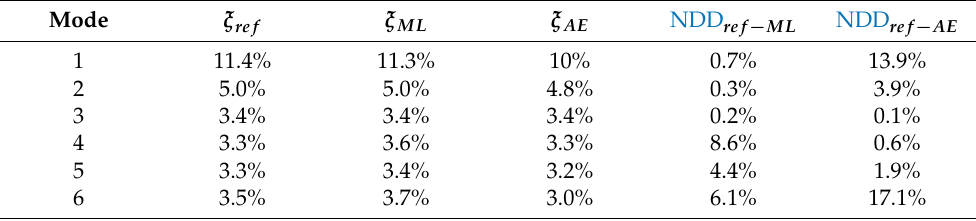
Table 4. Overview of the modal damping results for the synthetic data use case (see Section 3.1) show- ing the absolute values and the NDD for both the MATLAB ® (ML) and AutoEMA (AE) approach.